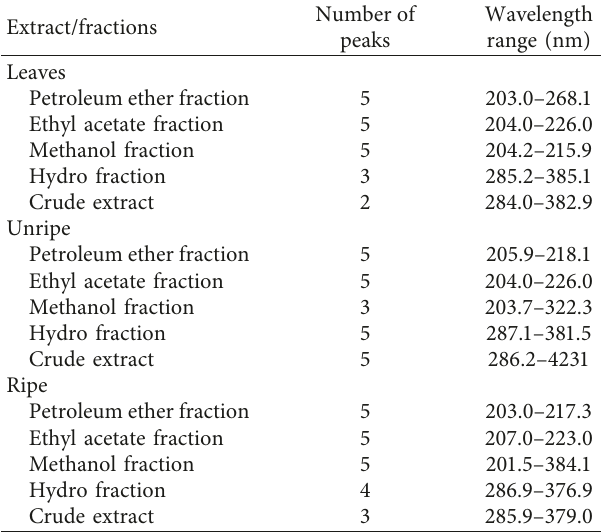
Table 3: UV-Vis peaks and absorption